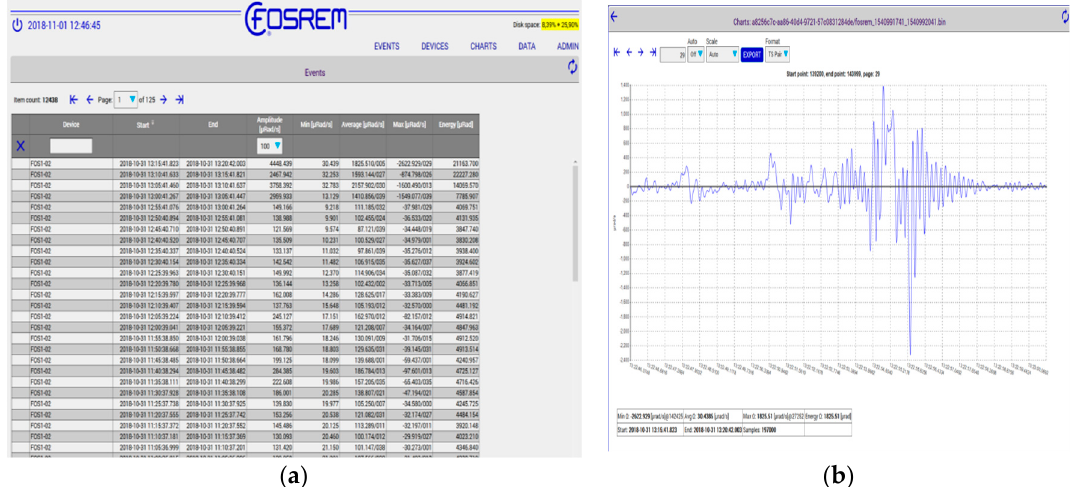
Figure 4. Print Screen for WEB FOSREM: ( a ) screen with selected and stored system events, ( b ) example of recorded seismic torsion event.